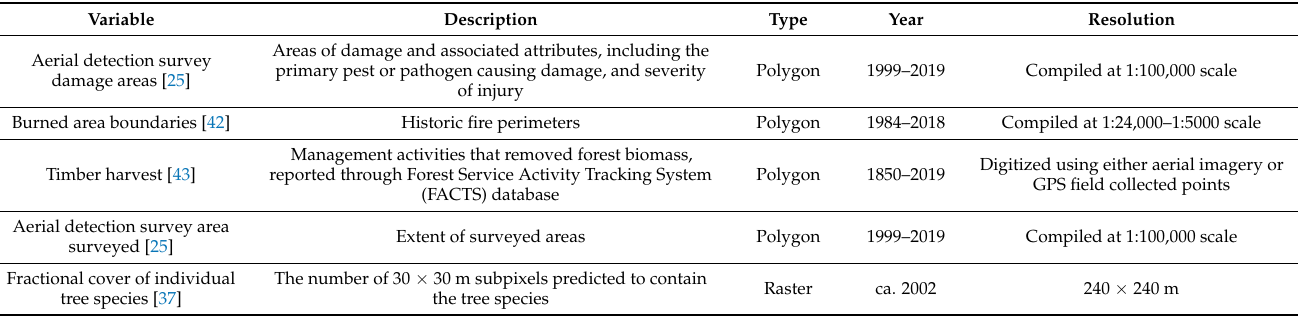
Table 1. Geospatial data